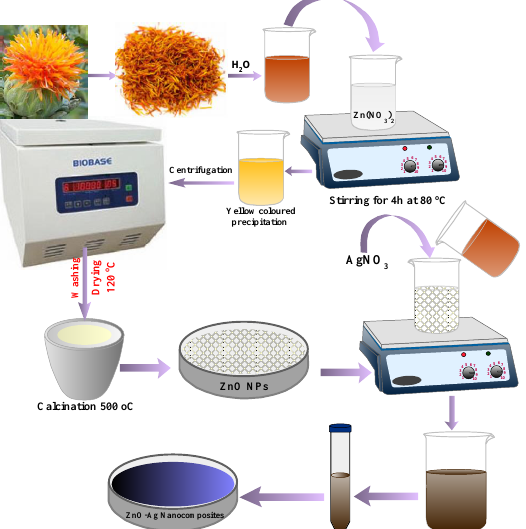
Figure 1. The proposed method for the preparation of ZnO NPs and ZnO – Ag nanocomposite.